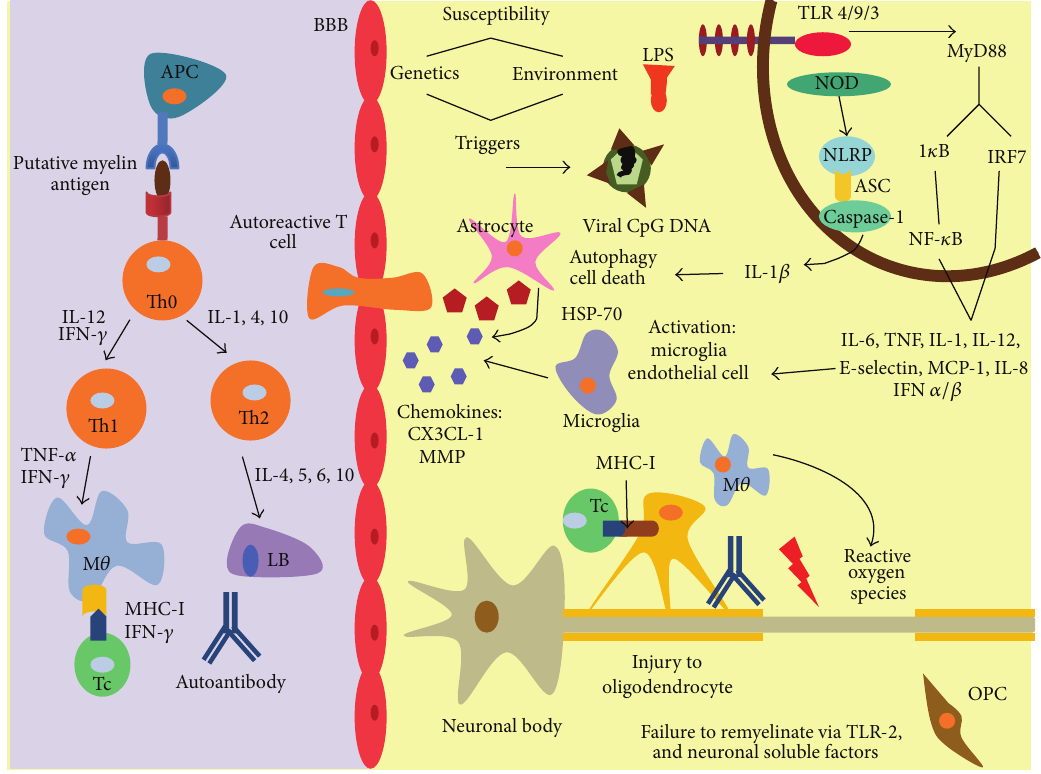
Figure 2: Multiple sclerosis pathophysiology. Contact in early childhood with a pathogen plus other susceptibility factors as racial and demographic background can elicit their reactivation, triggering innate mechanism of defense as toll-like receptors (TLRs), that signalizes downstream through MyD88 (myeloid differentiation primary response 88), and phosphorylated I 𝜅 B which permits translocation of NF- 𝜅 B and the transcription of IL-6, TNF, IL-1, IL-12, E-selectin, MCP-1, and IL-8. TLR through IRF7 (Interferon regulatory factor 7) gives the signal to the transcription of IFN 𝛼 / 𝛽 . Another important signal is given by NOD receptors (nucleotide-binding oligomerization domain) activated also by potassium efflux-inducing agents such as ATP and TLR stimulation; PAMS, toxins, danger or stress triggers induce the inflammasome via NLRP that forma complex with ASC (apoptosis-associatedspeck-like protein containing a CARD)and caspase-1, activating IL-1B,a major factor inducing inflammation, autophagy and cell death, particularly necrosis. All these proinflammatory soluble factors activate microglia and endothelial cells, upregulating expression of adhesion molecules as E-selectin, facilitating the migration of T cells into the SNC. Matrix metalloproteinases (MMP) degrades BBB (blood brain barrier) enhancing further migration of autoreactive T cells and macrophages via chemokines (CX3CL-1). The Th1 response evocated via IL-12 and IFN- 𝛾 further activates macrophages that in turn do so to T cells CD8+. Th2 response via IL-6 mainly stimulates maturation of B cells and production of autoantibodies. Cytotoxic damage to the oligodendrocyte mediated myelin loss and exposure of the axon to reactive oxygen species, slowing or blocking action potentials and the production of neurological spectrum. There are intents to remyelinate these lesions via OPCs (oligodendrocyte precursor cells), but neuronal factors such as LINGO-1 or TLR2 inhibit their